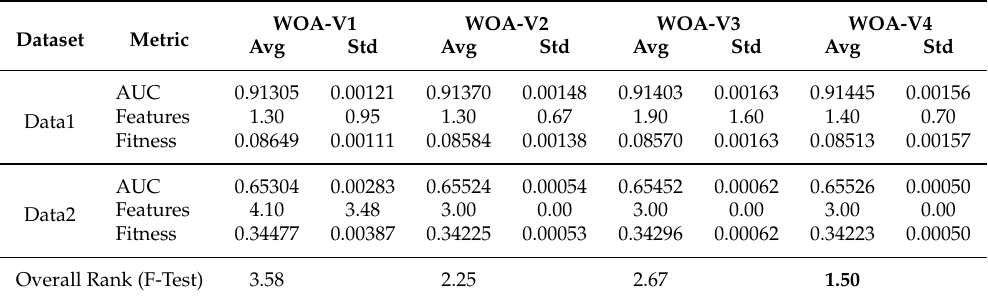
Table 10. Evaluation results of WOA using four V-shaped TFs in terms of average and standard deviation of AUC, No. selected features, and fitness values.